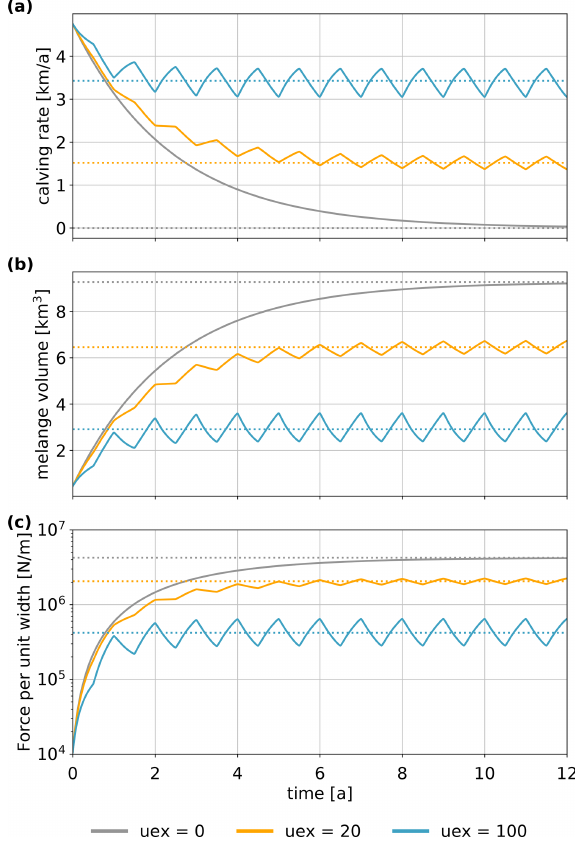
Figure 10. Evolution of the buttressed calving rate (a) , the mélange volume (b) , and the force per unit width at the calving front (c) in the case of no mélange exiting the embayment ( u ex = 0, grey lines) and for a seasonal variation in mélange exit velocity (orange and blue lines). The dotted lines show the corresponding equilibrium so- lution. For an equilibrated ice mélange, if no mélange exits the em- bayment ( u ex = 0), calving is completely suppressed ( C max = 0). However, in the time-dependent case and starting with a thin ini- tial mélange, calving is possible for some years. Seasonal varia- tions in the exit velocity lead to seasonal variations of the mélange- buttressing